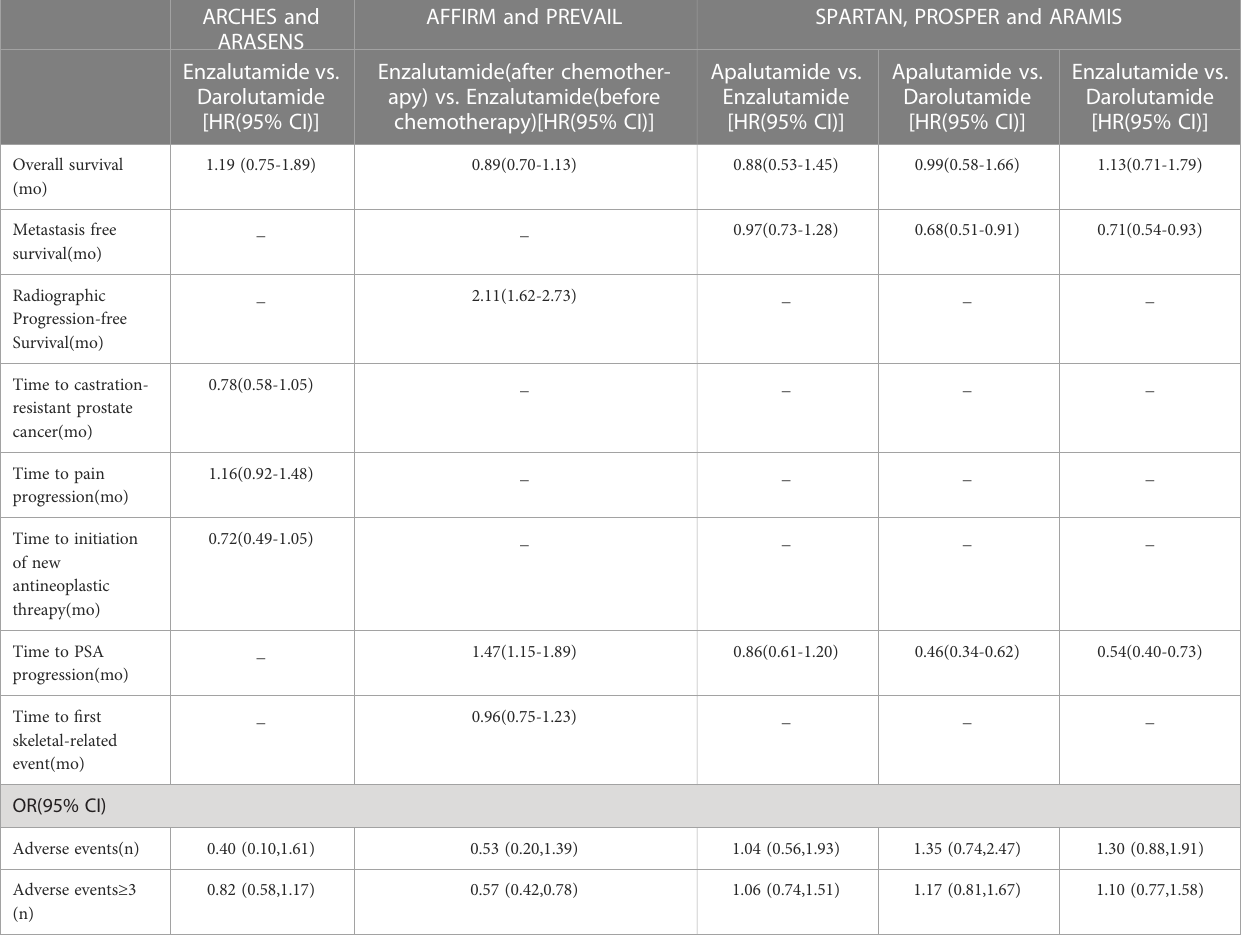
TABLE 3 Indirect comparison results for each SGARI.